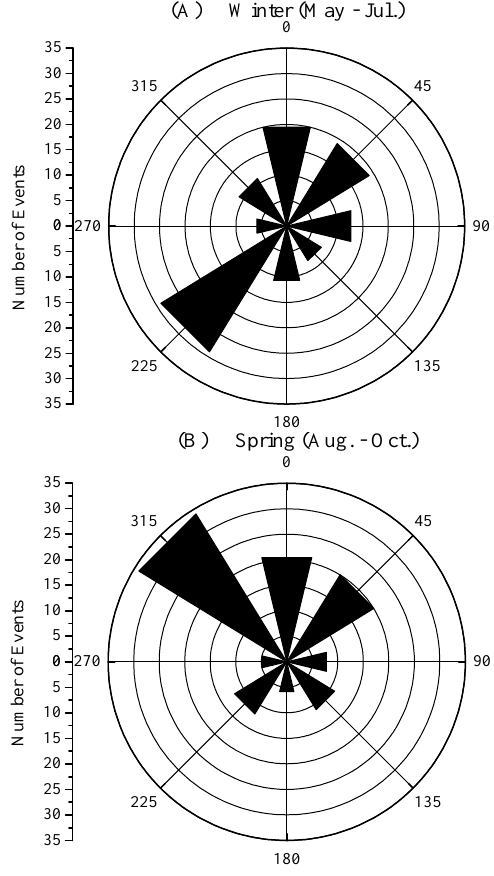
Fig. 5. Distribution of the gravity waves propagation direction as a function of the observed phase